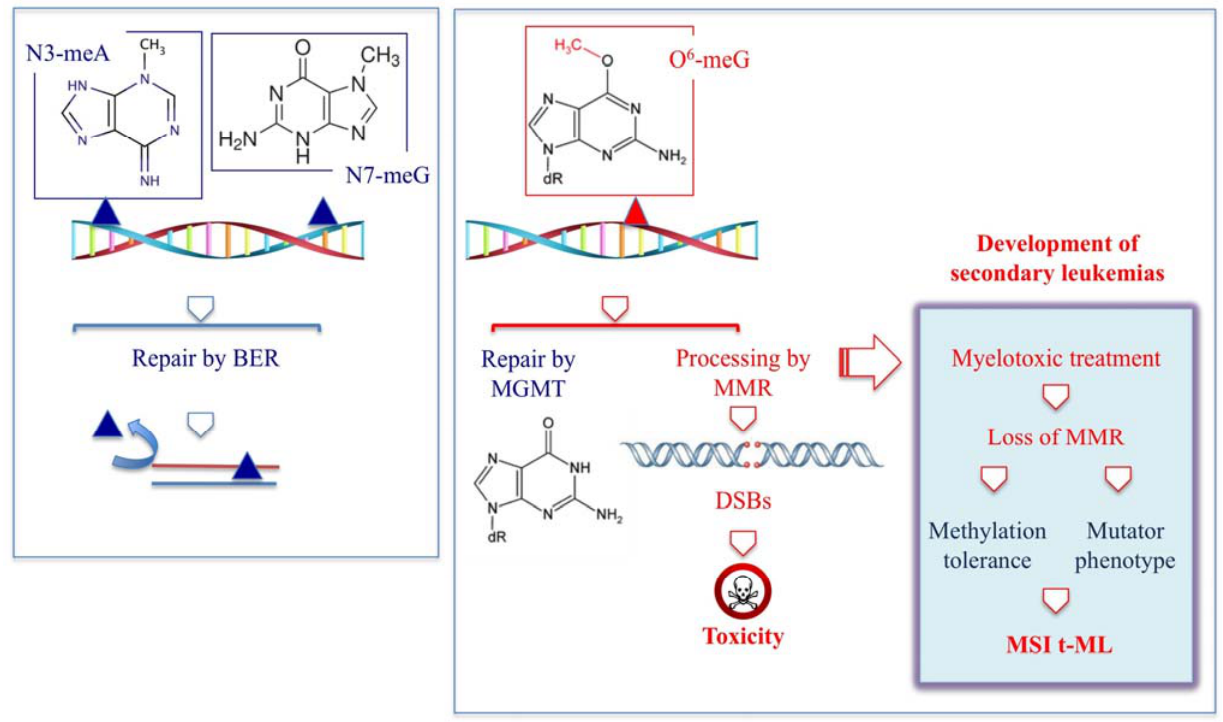
Figure 1. Repair and processing of DNA damage induced by monofunctional methylating